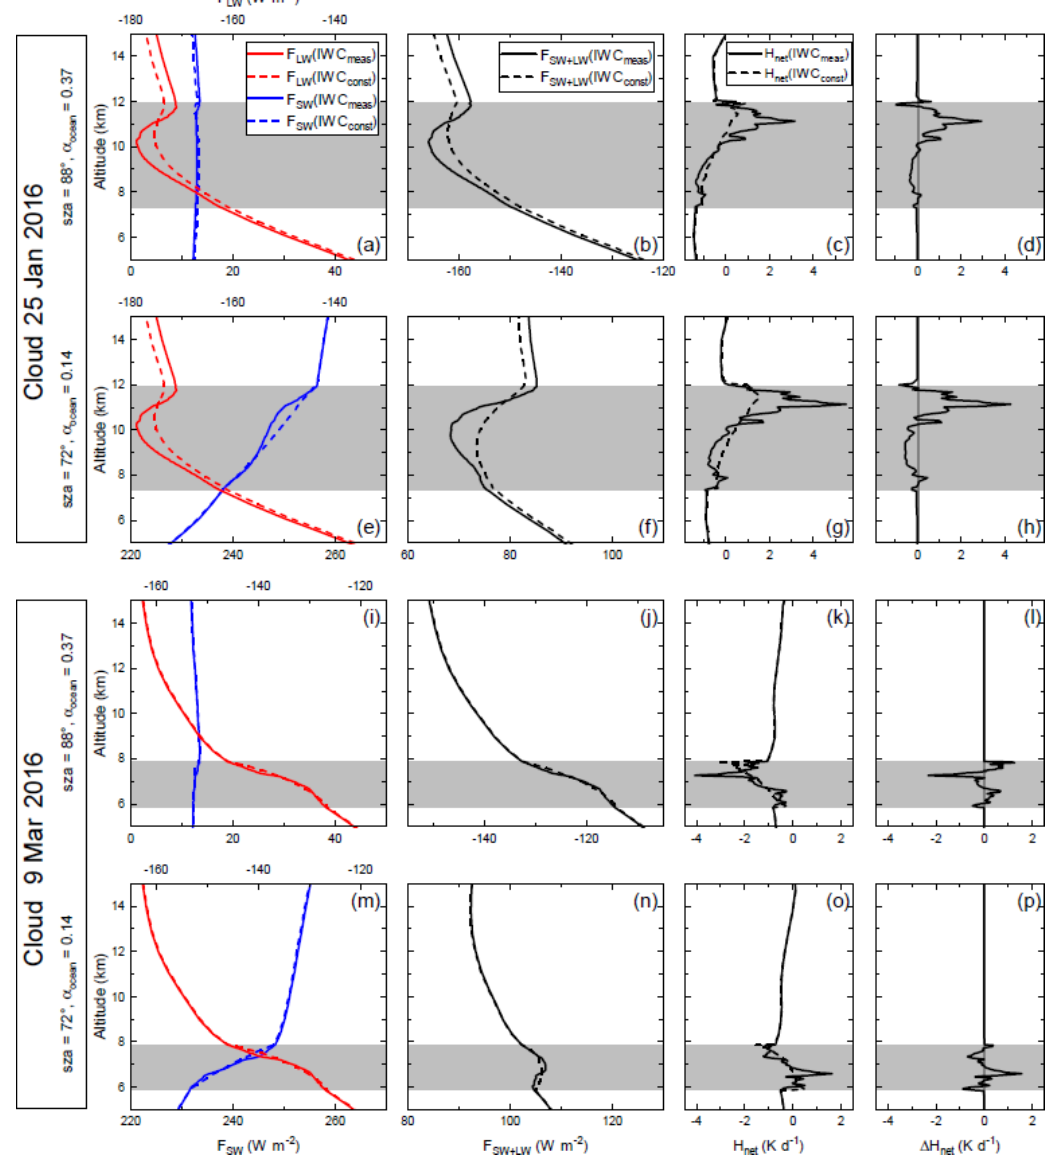
Figure 11. Irradiance profiles of measured (solid) and constant (dashed) IWC profiles for selected values of solar zenith angle and albedo as indicated. Panels (a) , (e) , (i) and (m) show the LW (red, top axis scale) and SW (blue, bottom axis scale) irradiances. The top axis is shown using negative numbers because F LW is directed upward. Panels (b) , (f) , (j) and (n) depict the net irradiances. All irradiance scales span a range of 50Wm − 2 , albeit at different absolute positions. Panels (c) , (g) , (k) and (o) show the net heating rate profiles of the measured and the constant IWC profiles. Panels (d) , (h) , (l) and (p) outline the difference between the net heating rate profiles of the measured and the constant IWC